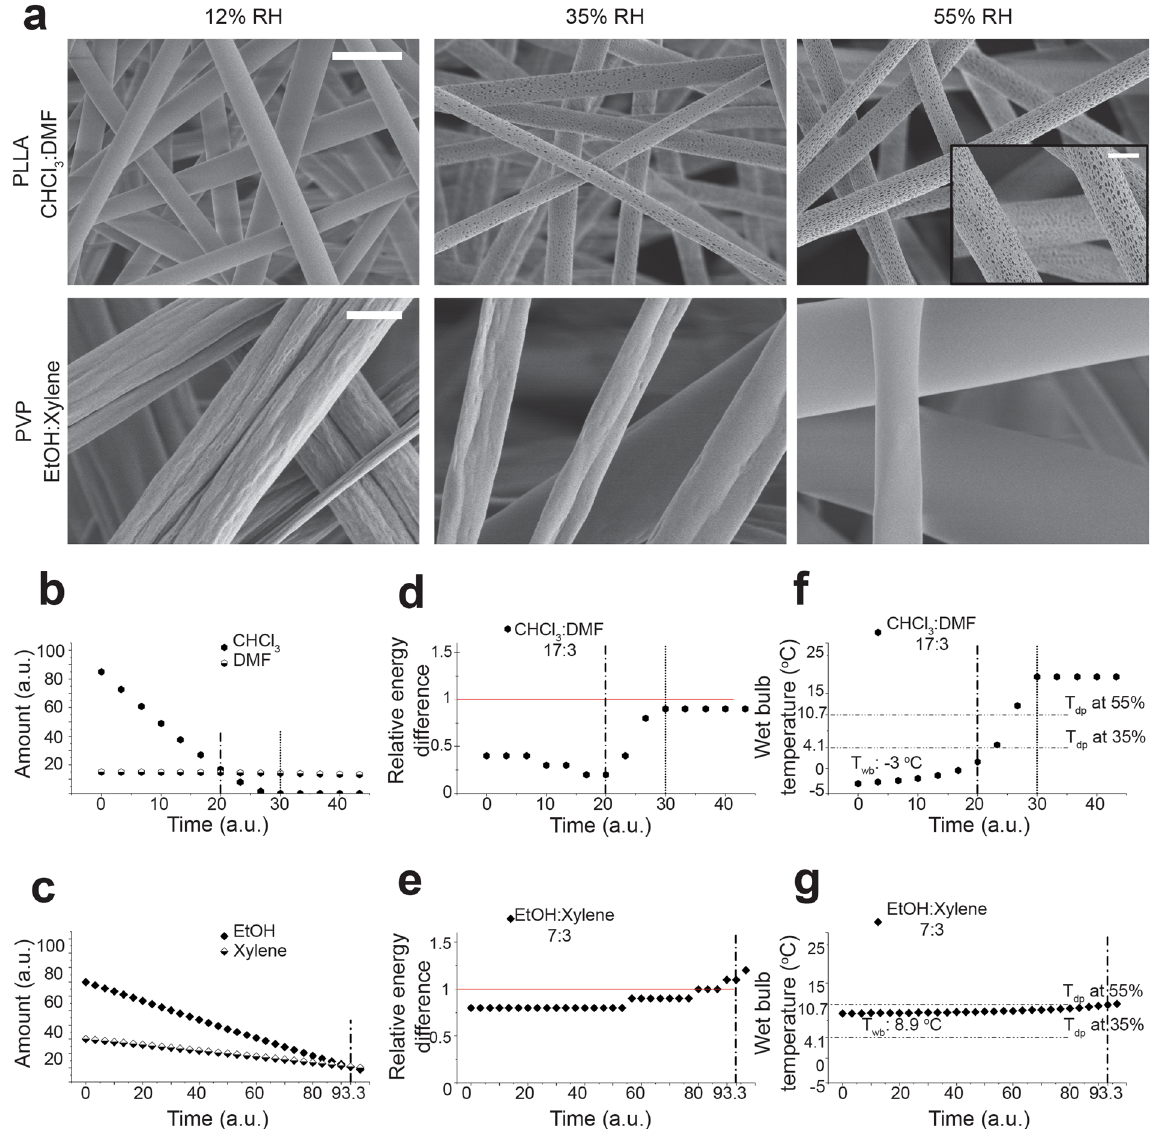
Figure 5. Resulting PLLA and PVP fiber morphologies, Simulated solvent evaporation and RED value changes during PLLA and PVP fiber formation: ( a ) SEM micrographs of PLLA electrospun fibers from CHCl 3 :DMF (17:3) solution (upper row) and PVP electrospun fibers from EtOH:Xylene (14:6) solution (lower row) at 12, 35, 55% RH, respectively (scale bar: upper row 5 µ m, inlet 2 µ m, lower row 1 µ m), simulated evaporation of ( b ) CHCl 3 and DMF and ( c ) EtOH and Xylene from PLLA and PVP solutions, respectively (assuming the initial total amount of a solution is 100 parts and the solvent amount changes by evaporation during electrospinning), simulated RED value change during solvent evaporation from ( d ) CHCl 3 :DMF and ( e ) EtOH:Xylene solutions, wet bulb temperature change (°C) during solvent evaporation from ( f ) CHCl 3 :DMF and ( g ) EtOH:Xylene solutions, (dash-dot line) last time point of similar amounts of solvent (S) and non-solvent; (round dot line) time point S = 0; (red line) solubility limit for the polymer in the solvent